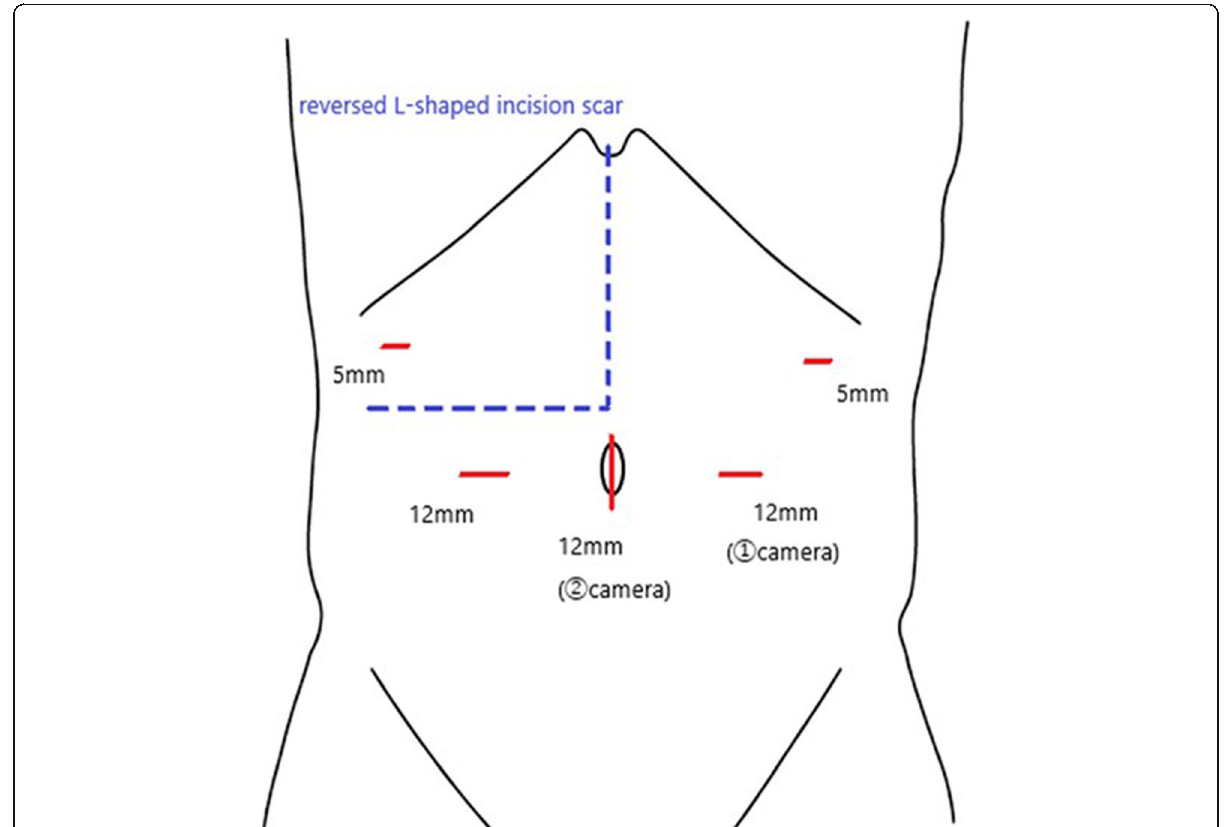
Fig. 1 The port location. The 1st port was inserted away from the reversed L-shaped incision